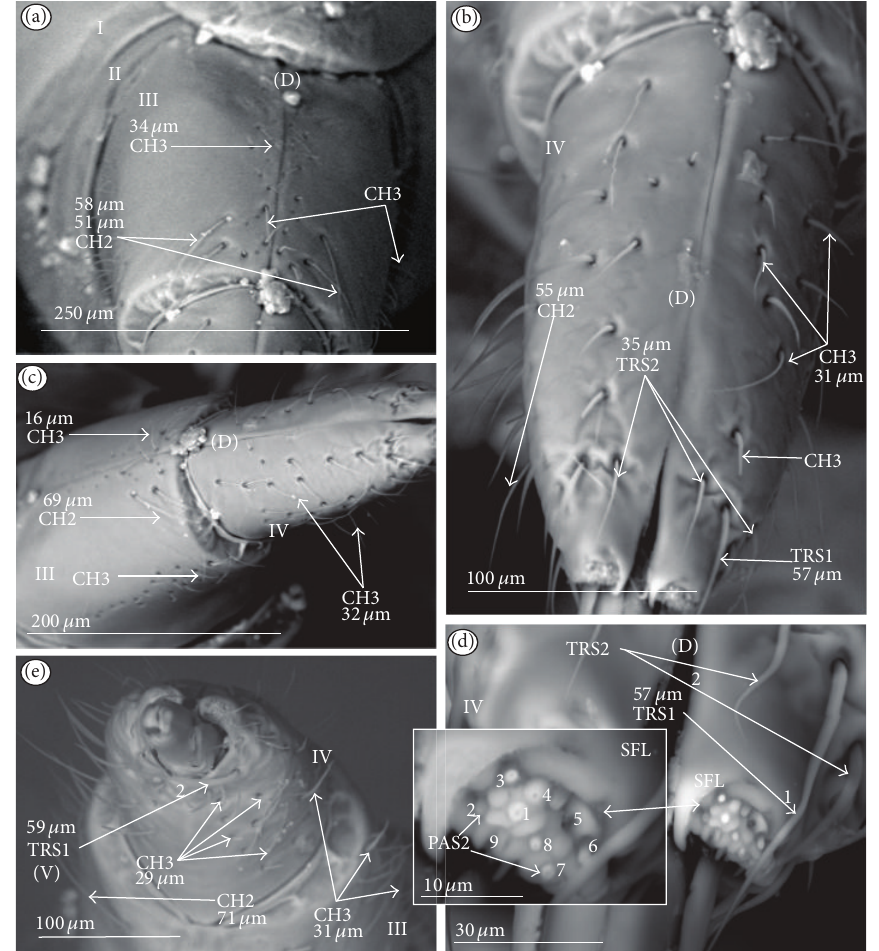
Figure 27: Types and sizes of the sensilla of the Notonectidae: Anisopinae ( Buenoa uhleri ). (a) Several CH3 and CH2 are present on the III segment (dorsal view). (b) Several CH3 and CH2 are present on the IV segment (dorsal view). (c) Several CH3 are scattered all over the surface of the IV segment (lateral view), two CH2 are situated near the distal edge of the III segment, and CH3 are situated in rows dorsally and laterally. (d) TRS1 (one) and TRS2 (two) are distributed over the dorsal side (D) near the apex of the labium; PAS2 (no. 1–9) are situated on the sensory field (left-side view; SFL). (e) Several CH3 are visible on the ventral side of the IV and III segments; TRS1 (two) are situated ventrally near the